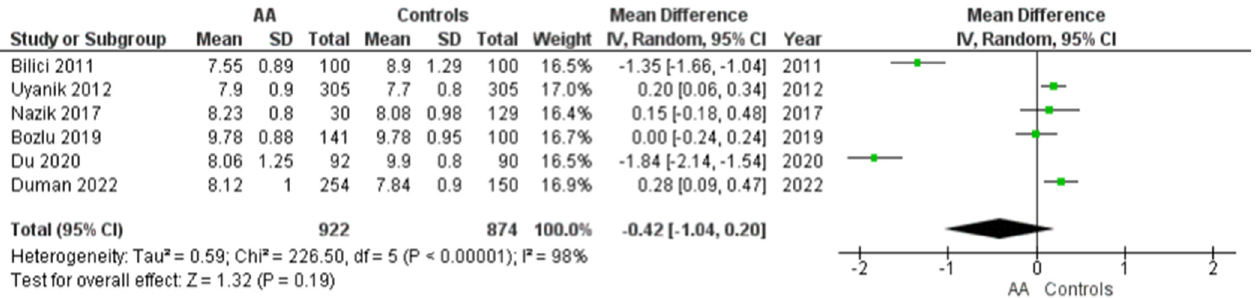
Figure 2. Forest plot comparison between the two patient groups (AA versus healthy controls) in terms of the average values of mean platelet volume. Abbreviations: AA, acute appendicitis; IV, inverse variance; CI, confidence interval.